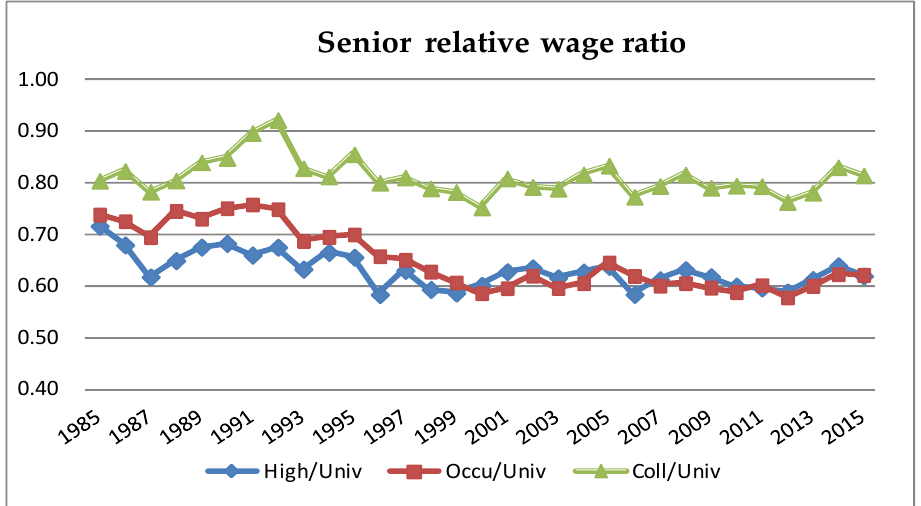
Figure 6. Senior relative wage ratio. Source: same as Figure 1.